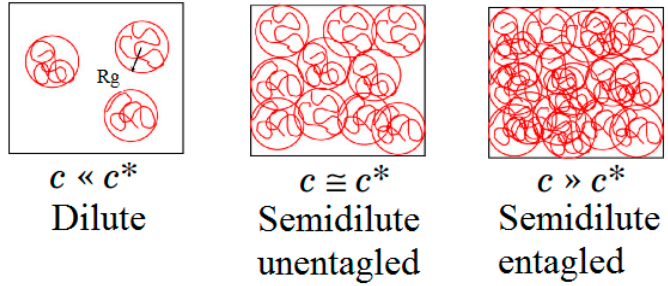
Figure 6. Model prediction for solution viscosity as a function of ( a ) polymer concentration, ( b ) sulfonation degree, ( c ) molecular weight, ( d ) salinity concentration, ( e ) hardness concentration, ( f ) temperature, ( g ) aging time and ( h ) shear rate.